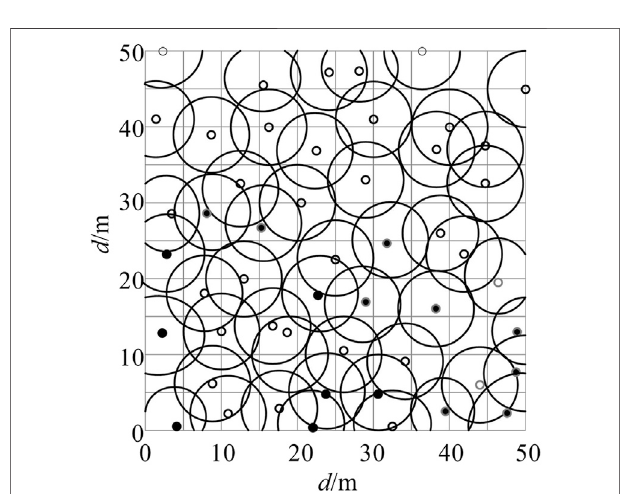
FIGURE 8 | Recovery after irregular failure.